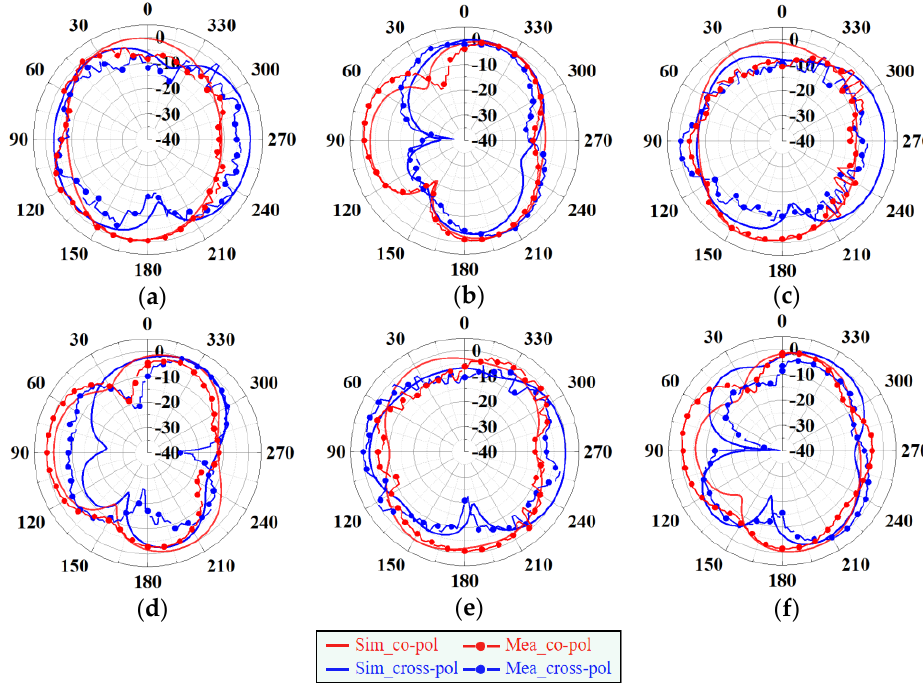
Figure 13. The measured and simulated 2D radiation patterns of the proposed antenna. ( a ) E-plane at 5.2 GHz. ( b ) H-plane at 5.2 GHz. ( c ) E-plane at 5.5 GHz. ( d ) H-plane at 5.5 GHz. ( e ) E-plane at 5.8 GHz. ( f ) H-plane at 5.8 GHz.